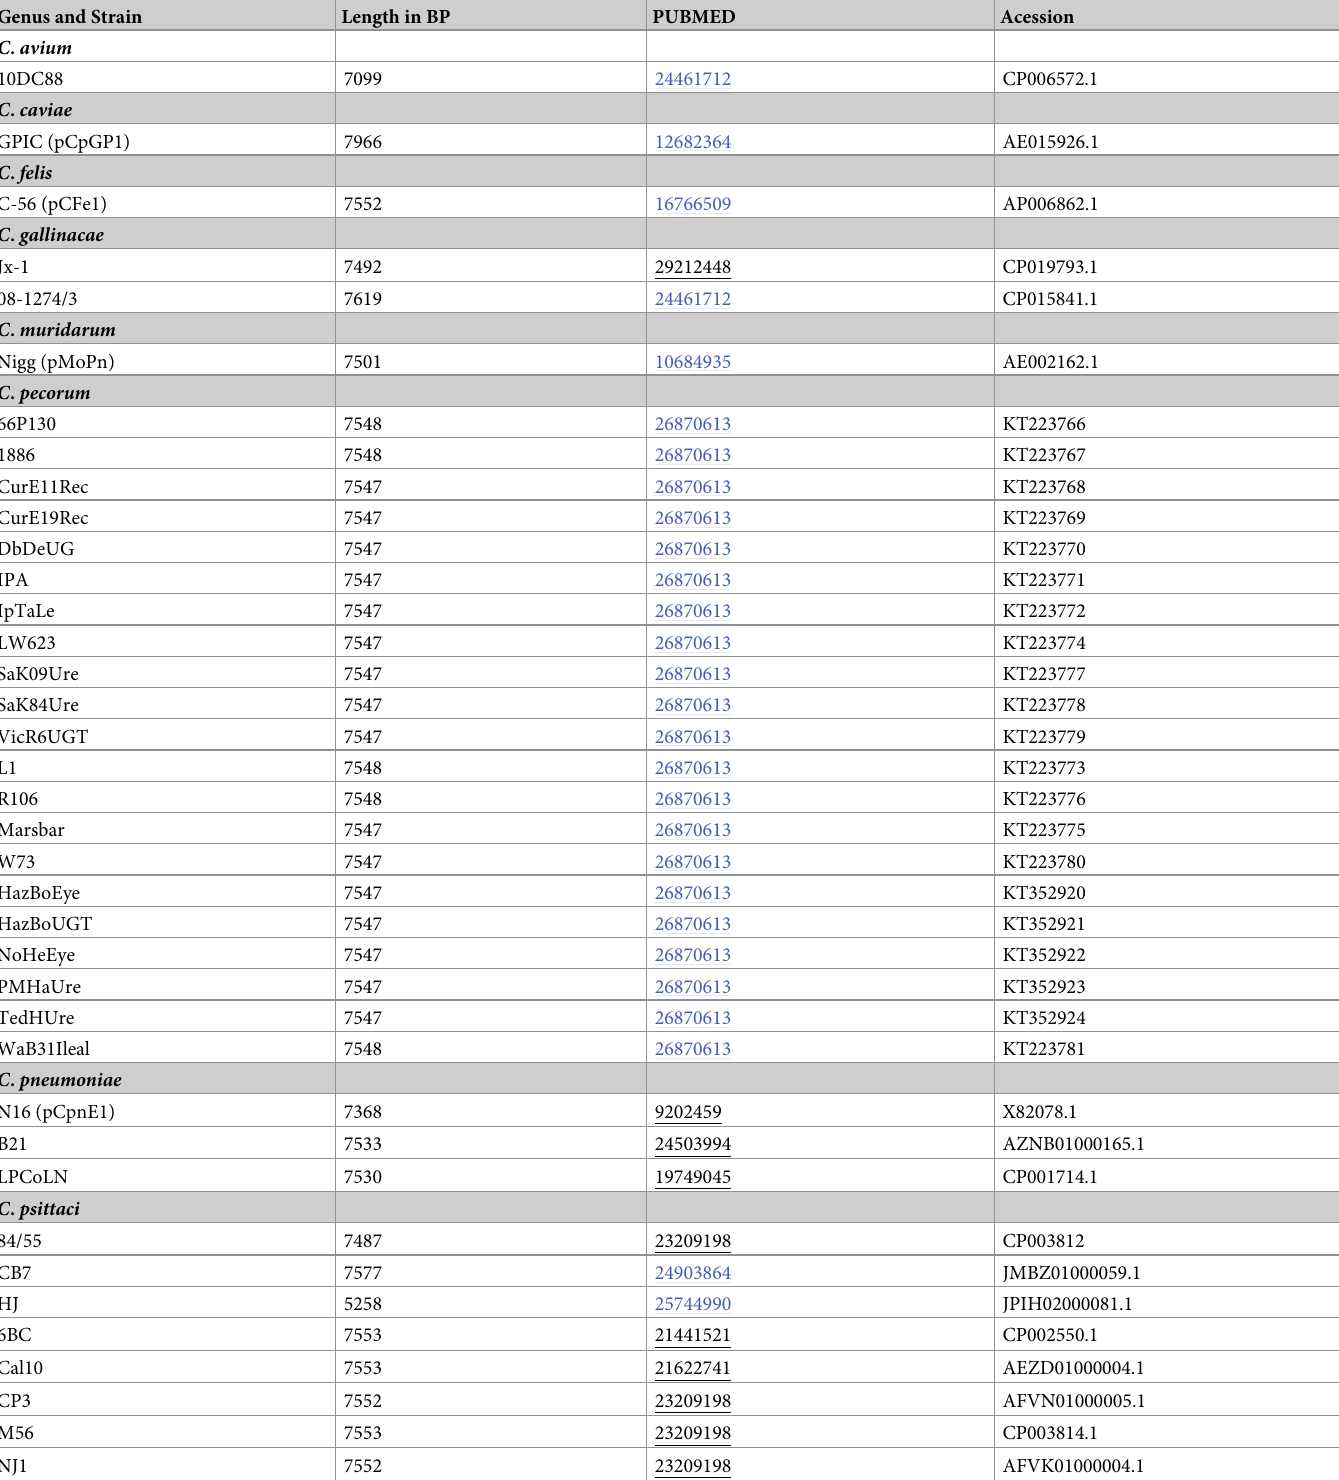
Table 1. List of all the Chlamydial species that are being used for the study. Relevant information on length of plasmid, accession number, PUBMED ID and source provided. Genus and